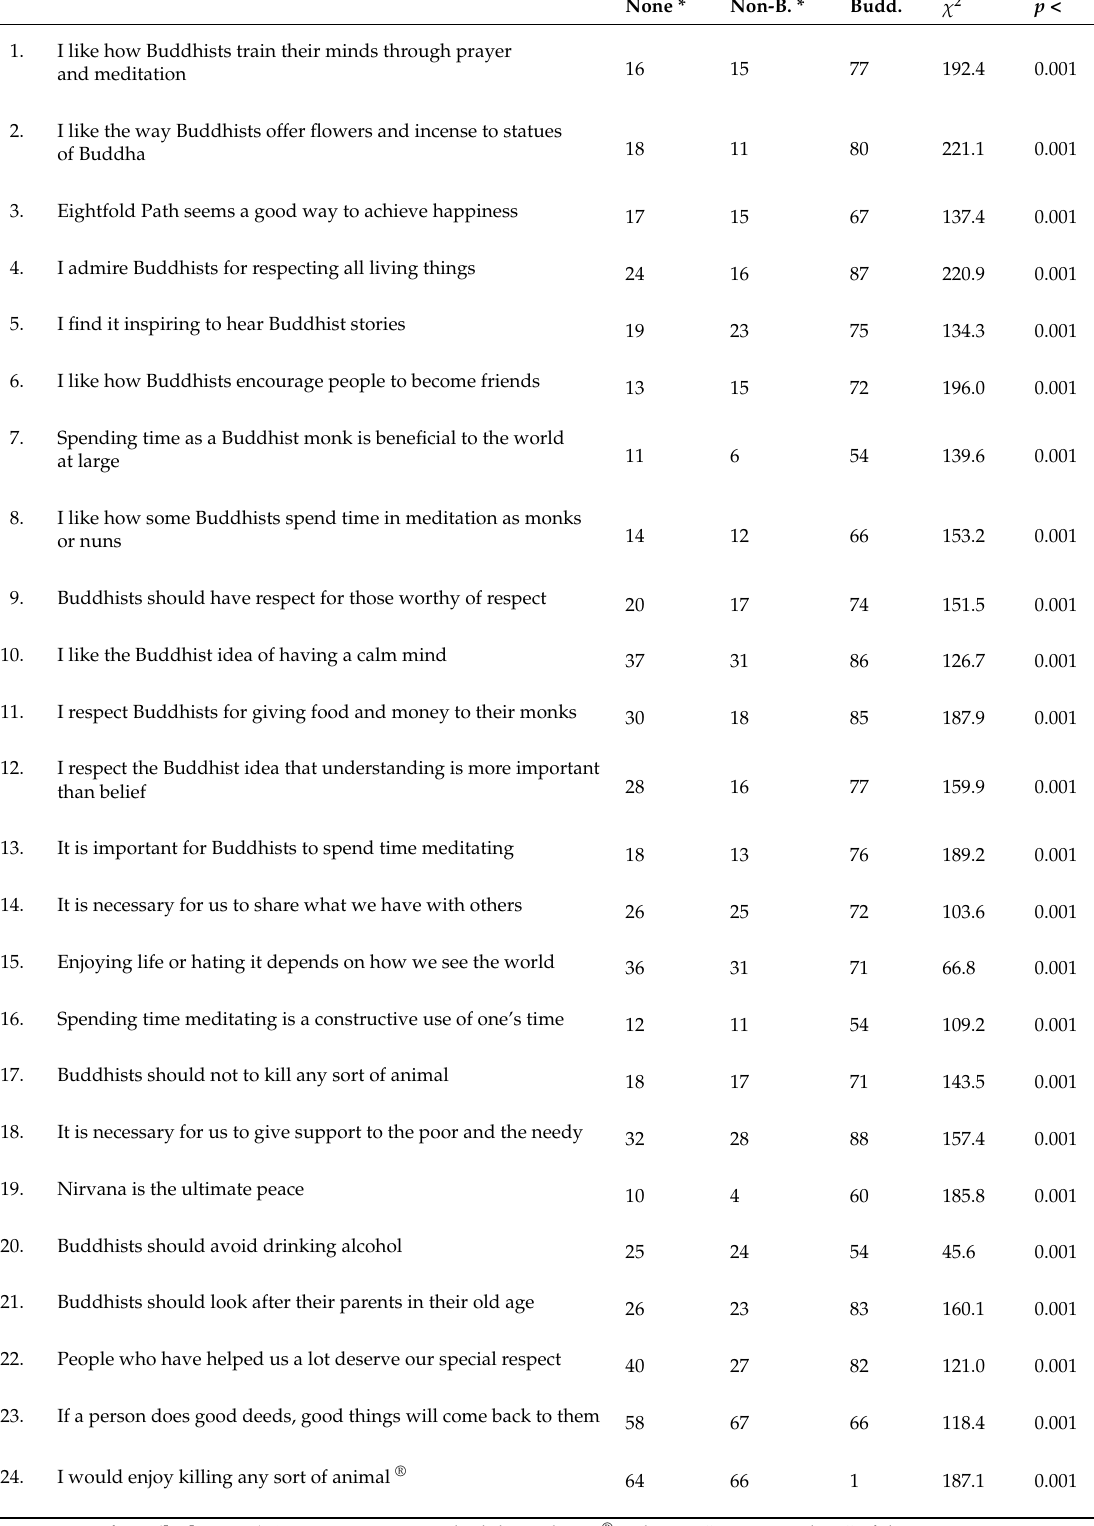
Table 1. Comparison of attitude towards Buddhism between adolescents of no religion, non-Buddhist religion and Buddhist religion.